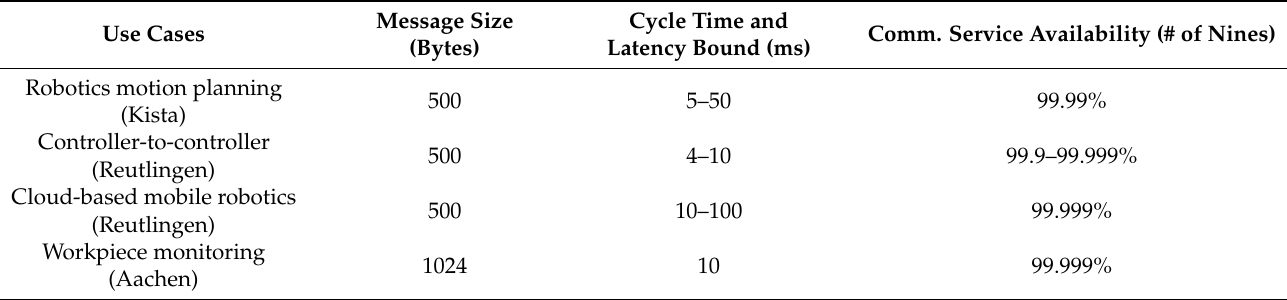
Table 1. Industrial use cases and their